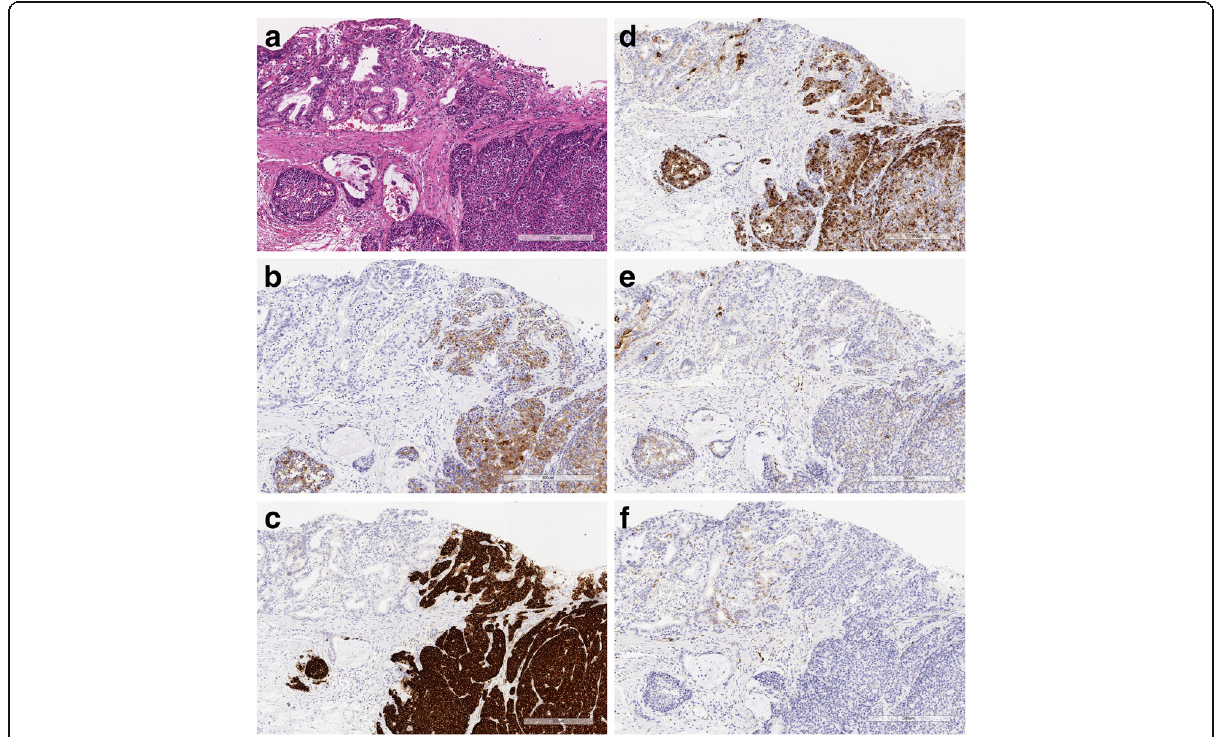
Fig. 2 Immunohistochemical analysis of tumor components. a Hematoxylin and eosin (H&E)-stained specimen. b - f Immunohistochemical examinations. b Trypsin, c BCL10 and d Chromogranin A were positive in the solid component. e Synaptophysin and f CD56 were negative Table 2. The results of the AI analysis are also shown in Table 2. Although AI was detected on chromosomes 5q, 8p, 11q and 22q in the solid component, AI was detected only on chromosome 11q in the glandular component (Figs. 3a-i).